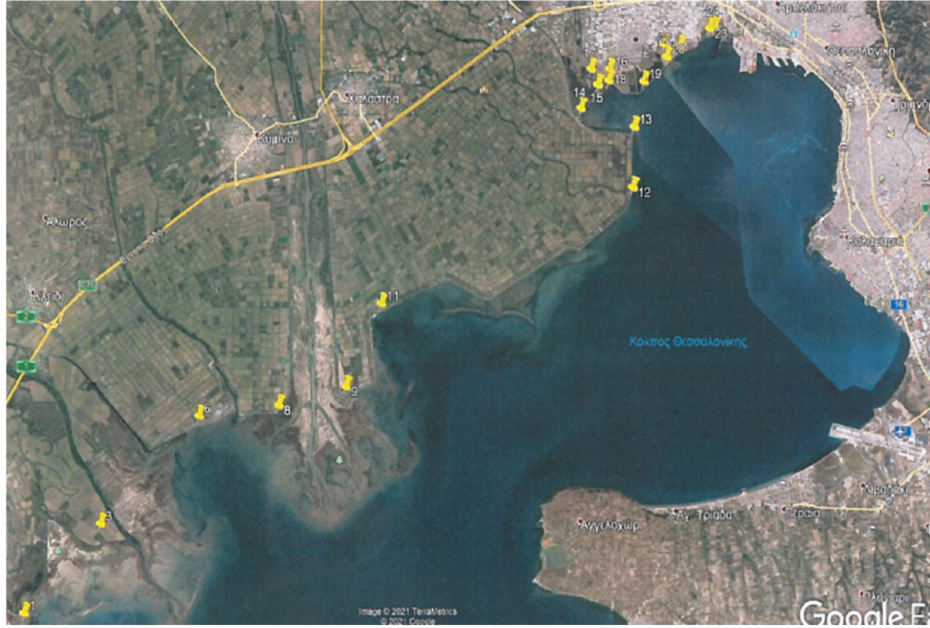
Figure 18. Locations of the selected ground points (1-19) within the study area that were measured in the GNSS